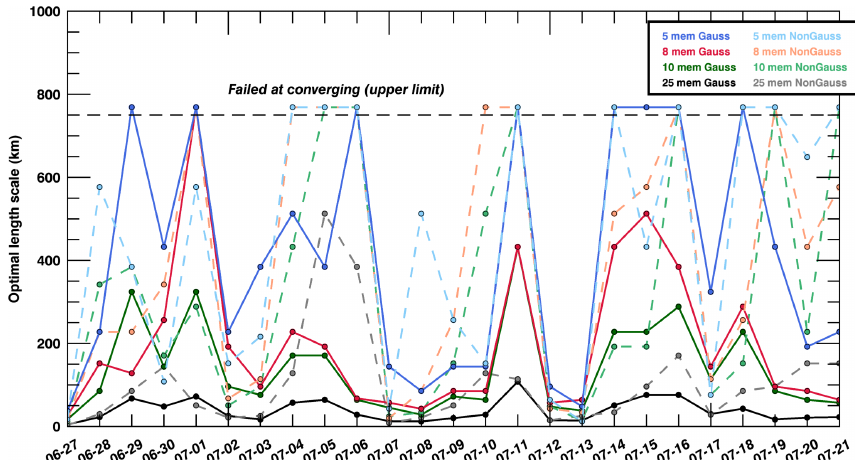
Figure 2. Length scale (in km) of the variance filter for in situ CO 2 mole fractions at about 100ma.g.l. using Gaussian (solid lines) and non-Gaussian (dash lines) equations from 27 June to 21 July 2008.